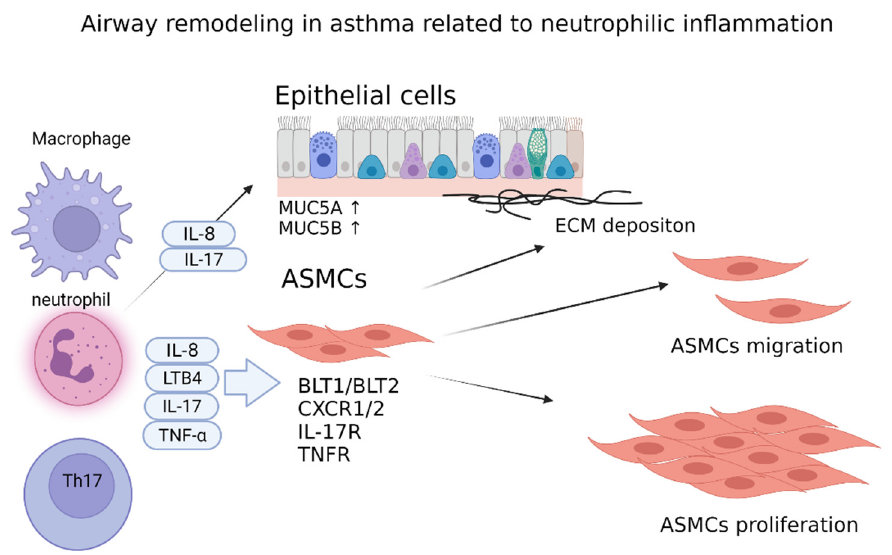
Figure 2. Airway remodeling in asthma related to neutrophilic inflammation. Airway remodeling in asthma is a characteristic feature of chronic asthma. LTB4, IL-8, LTB4, and TNF- α are elevated in an asthmatic airway and are related to airway remodeling. LTB4, IL-8, and TNF- α induce airway smooth muscle cell proliferation and migration. IL-8 and IL-17 upregulate MUC5A and MUC5B expression in epithelial cells. Abbreviations: IL, interleukin; LTB4, leukotriene B4, TNF- α ; Tumor necrosis factor α , BLT1/2: leukotriene B4 receptor 1/2, IL-17R: IL-17 receptor, TNFR: TNF receptor, ASMCs: airway smooth muscle cells.